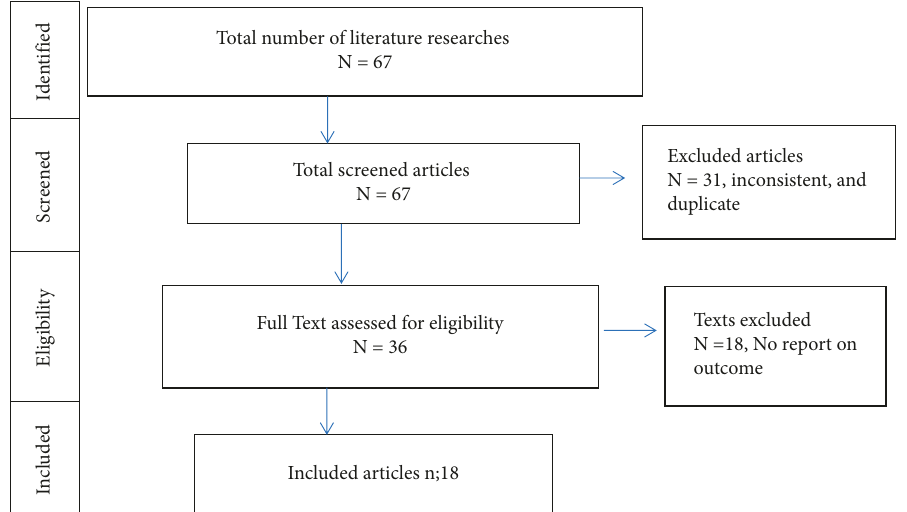
Figure 1: PRISMA flow chart for showing the screening and selection process of